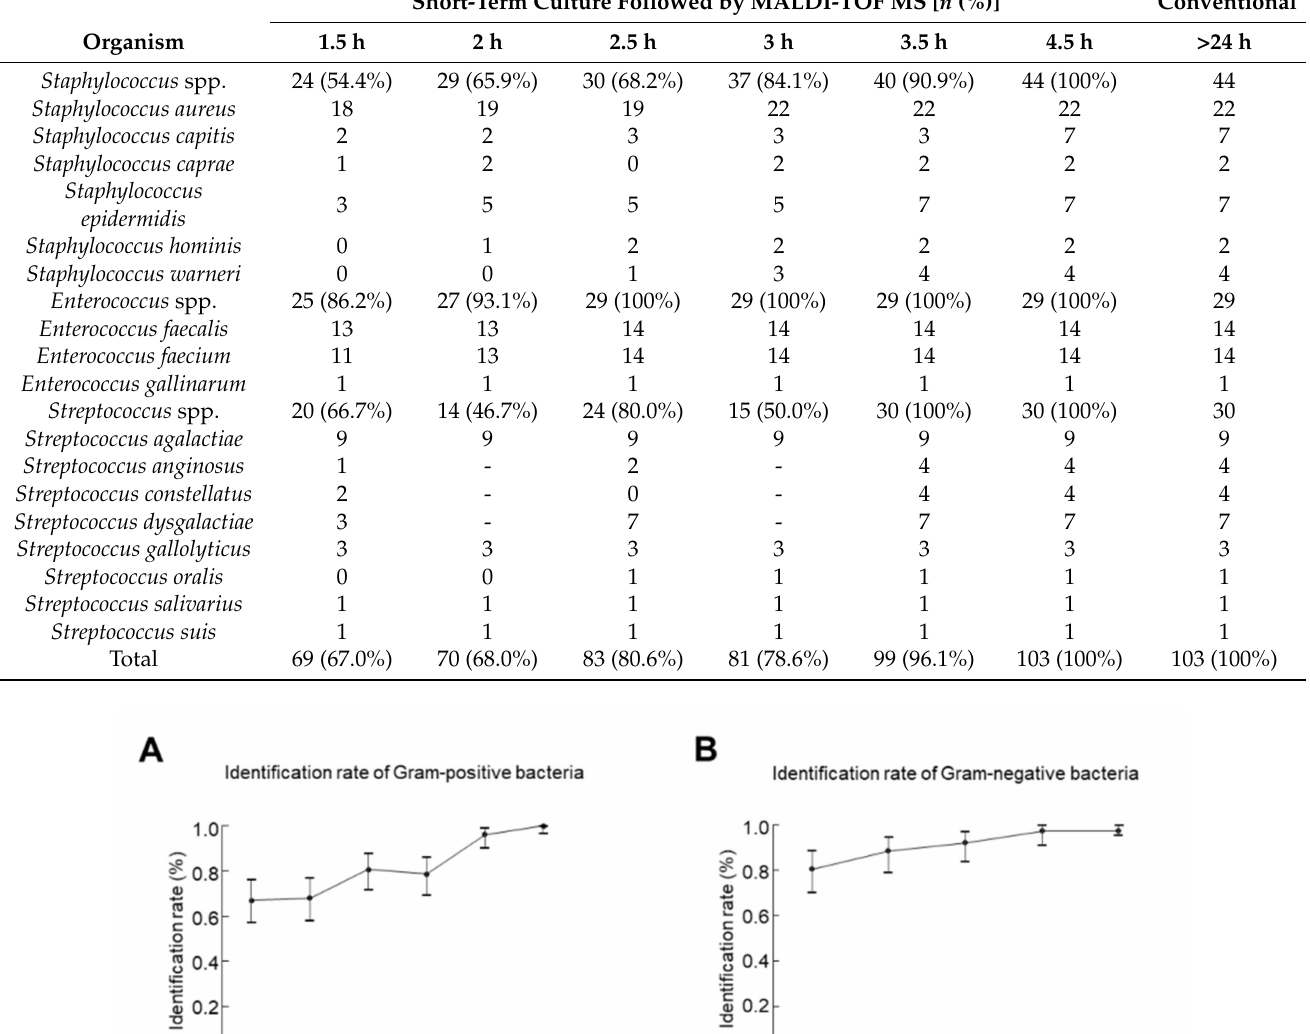
Table 1. Gram-positive bacteria identified by the short-term incubation (4.5 h) were concordant to those from the conven- tional method.